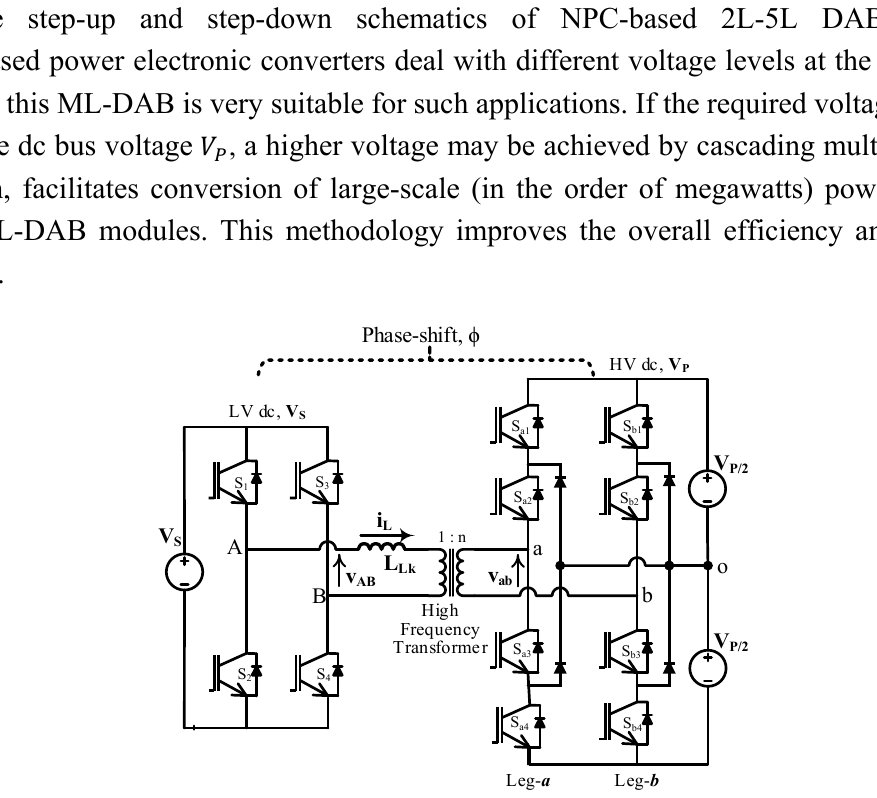
) of a multilevel dual active bridge (ML-DAB), where (cid:3017) > (cid:1848) (cid:3046) ) is two-level (2L) and the secondary ( (cid:1874) (cid:3002)(cid:3003)